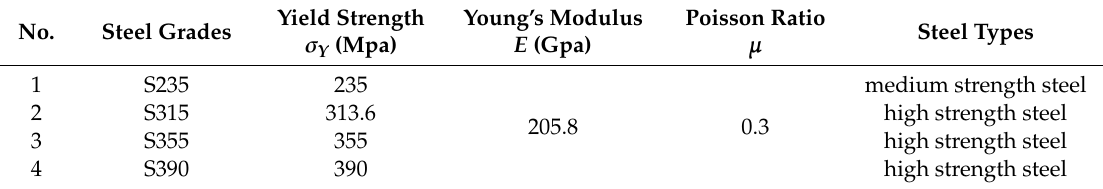
Table 3. Employed shipbuilding steels and their basic mechanical